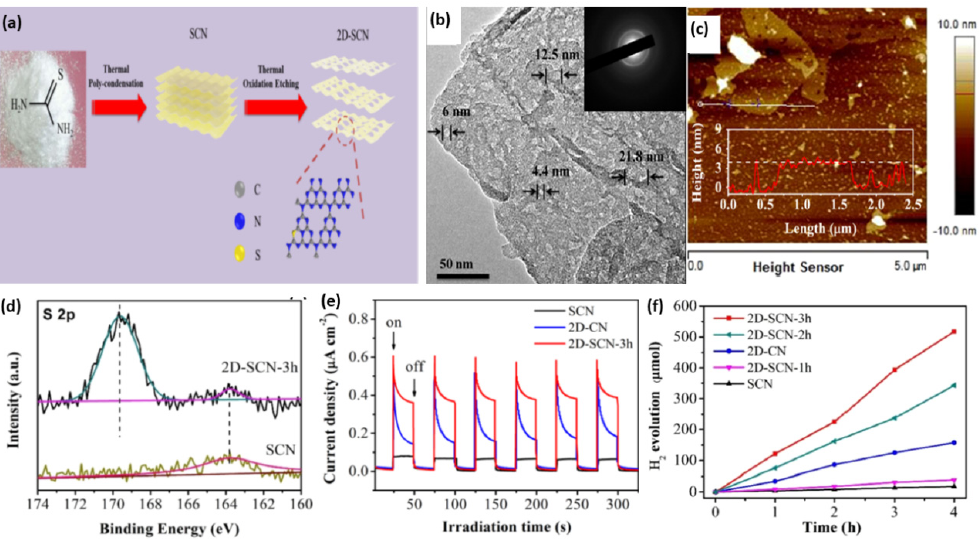
Figure 6. ( a ) Schematic illustration of the synthesis procedure of 2D-SCN. ( b ) TEM image and ( c ) AFM image of 2D-SCN-3h. ( d ) S 2p XPS spectra of SCN and 2D-SCN-3h. ( e ) Transient photocurrent–time curves, and ( f ) H 2 production on 2D-SCN-3h, 2D-SCN-2h, 2D-SCN-1h, SCN, 2D-SCN, and 2D CN. Adapted with permission from Ref. [108]. 2020, American Chemical Society.